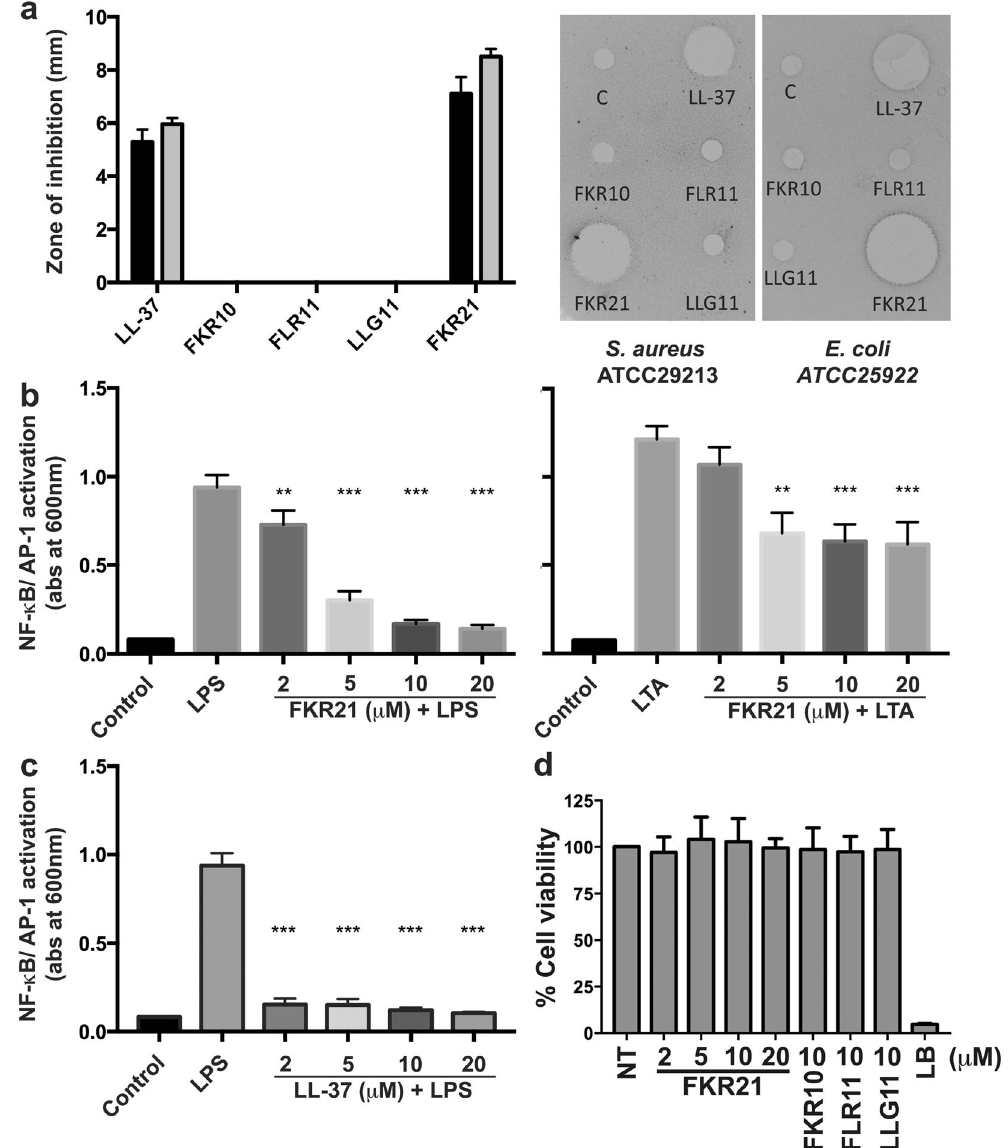
Figure 4. Antimicrobial and immune-modulatory effects of LL-37 and peptide fragments. ( a ) Determination of antimicrobial activity (using radial diffusion assay, RDA) of the peptide fragments (FKR10, FLR11, LLG11 and FKR21) and LL-37 (100 μ M) against S . aureus ATCC29213 (black bars) and E . coli ATCC25922 (grey bars) (n = 6). The right panel illustrates two scanned examples of representative RDA gels visualizing the zones of clearance corresponding to the inhibitory effects of the peptides against S . aureus and E . coli after incubation at 37 °C for 18–24 h (C, control, buffer 10 mM Tris pH 7.4). ( b ) Evaluation of NF- κ B/AP-1 activation in supernatants of THP1-X-Blue CD14 cells after stimulation with 100 ng/ml of E . coli LPS (left) or 1 μ g/ml of S . aureus LTA (right) and increasing concentrations of FKR21. ( c ) Evaluation of NF- κ B/AP-1 activation in supernatants of THP1-X-Blue CD14 cells after stimulation with 100 ng/ml of E . coli LPS and increasing concentrations of LL-37 are shown for comparison. ( d ) Cell viability of HaCaT keratinocytes was analysed using a MTT assay. The results are indicated as mean absorbance values after treatment by the LL-37 derived peptide fragments, which correspond to the amount of living cells, and are compared to the control representing non-treated (NT) cells. Lysis Buffer (LB) yielded 100% lysis of the cells, mean values and SD of at least three independent experiments are presented ( ** P < 0.01, *** P <